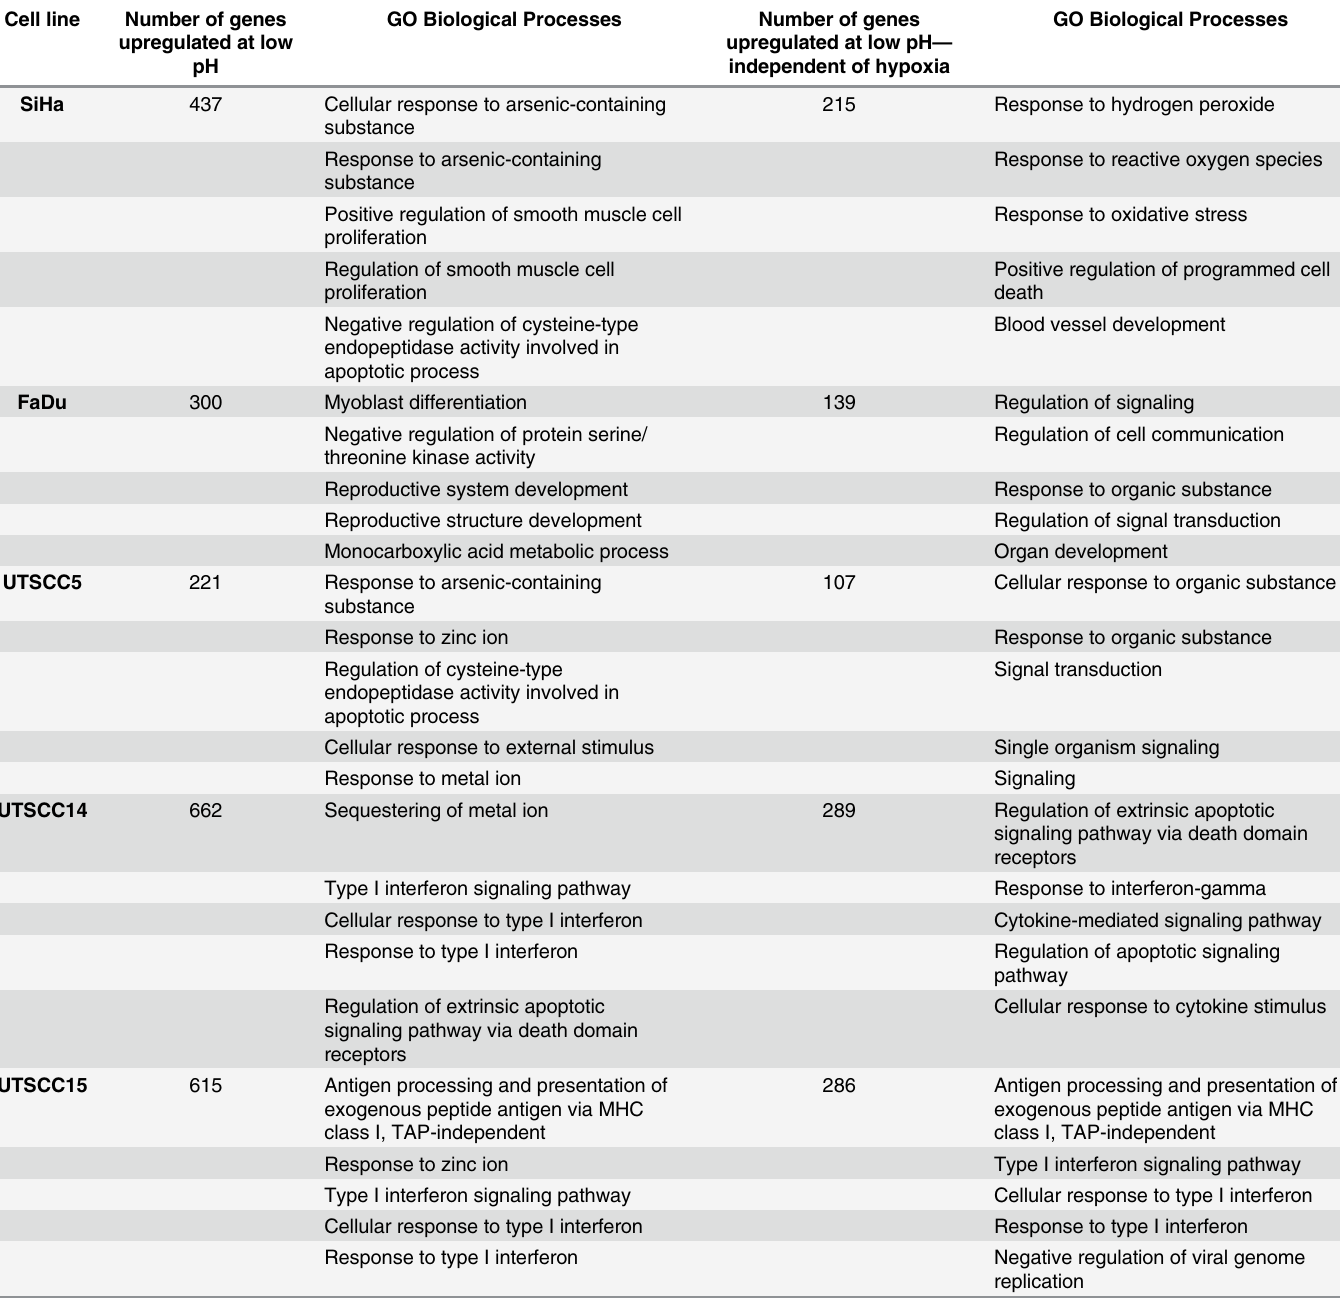
Table 1. Number of upregulated genes in individual cell lines and top five of GO Biological Processes for each gene set. Cell line Number of genes upregulated at